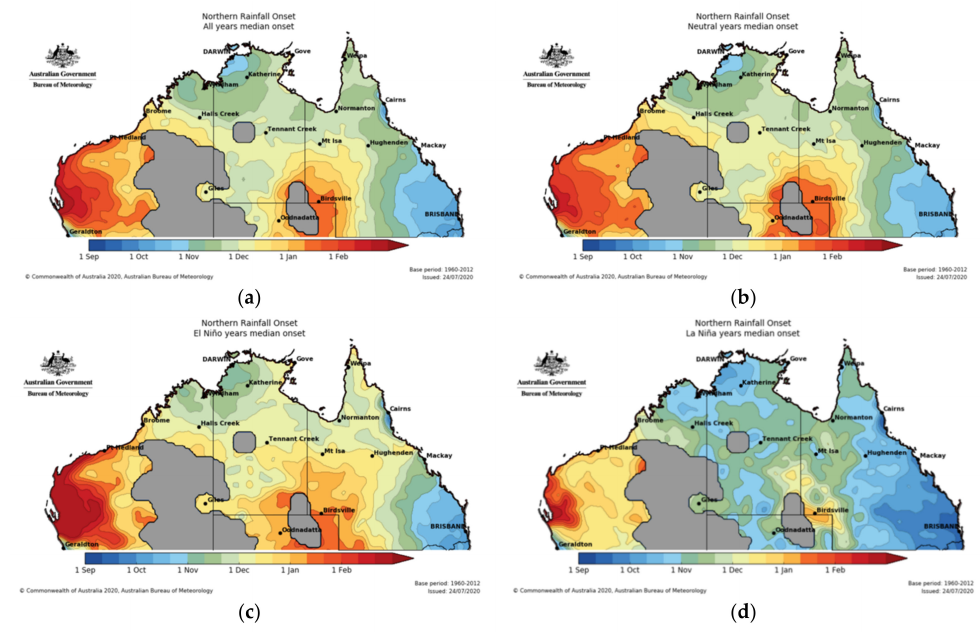
Figure 2. Northern rainfall onset medians showing differences in timing and trends of seasons: ( a ) All years median onset, ( b ) Neutral years median onset, ( c ) El Niño years median onset,